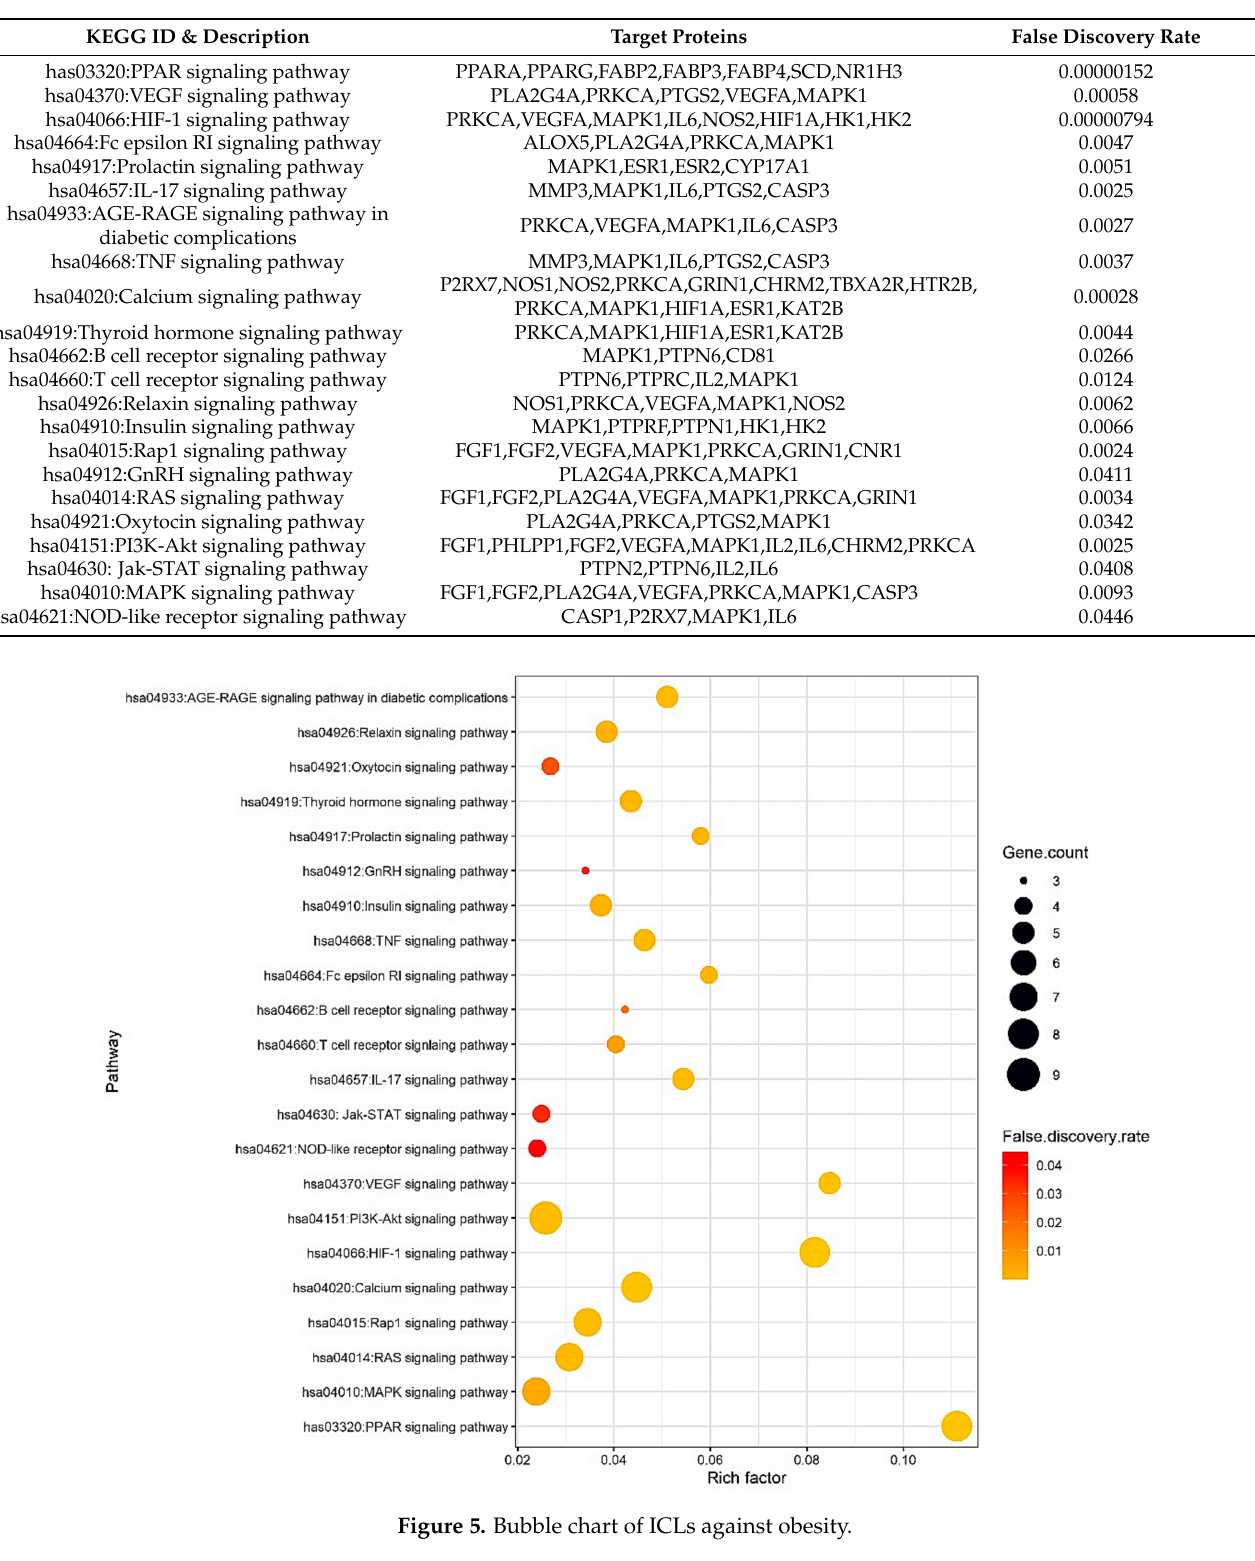
Table 4. The number of 42 target proteins in 22 signaling pathways enrichment associated with obesity.